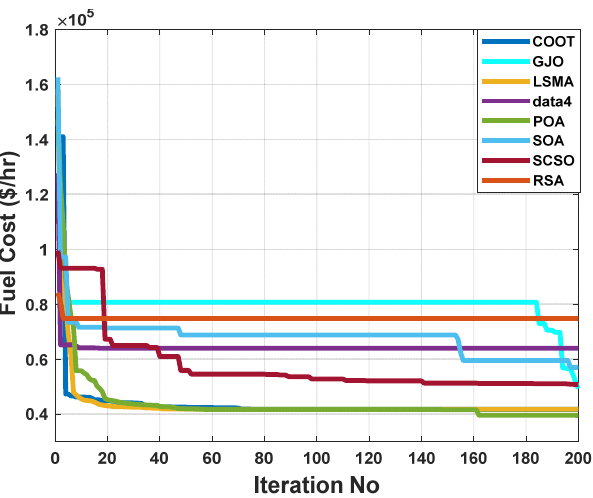
Figure 19. The convergence characteristics of POA and other compared algorithms for case 1 in a standard IEEE 57-bus test system.